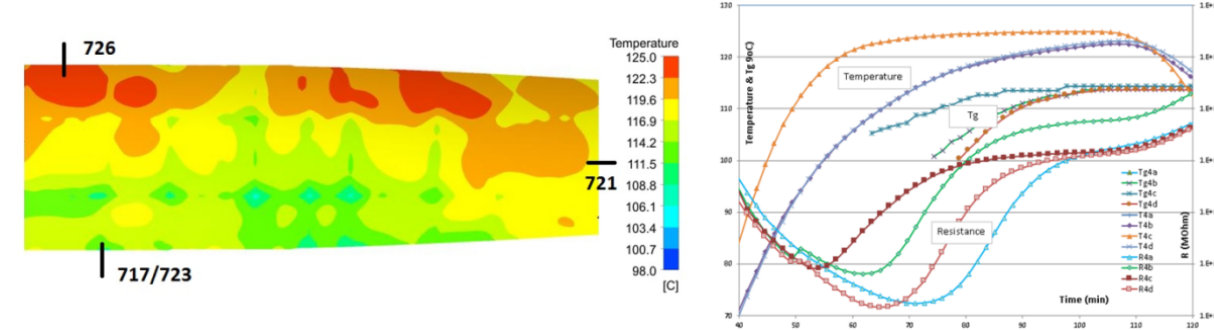
Figure 7: Simulated cold and hot spots areas (left), sensor data from the DEA (right), ©